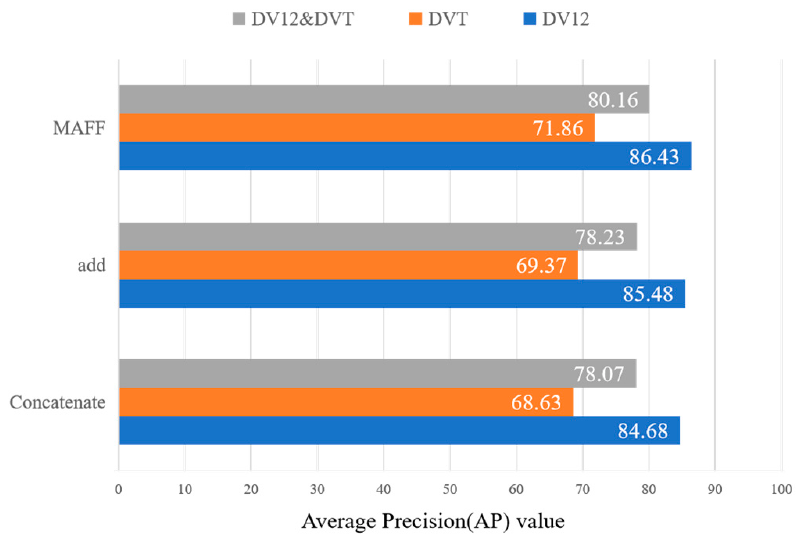
Figure 14. The detection results of different feature-fusion methods in different growth cycle data